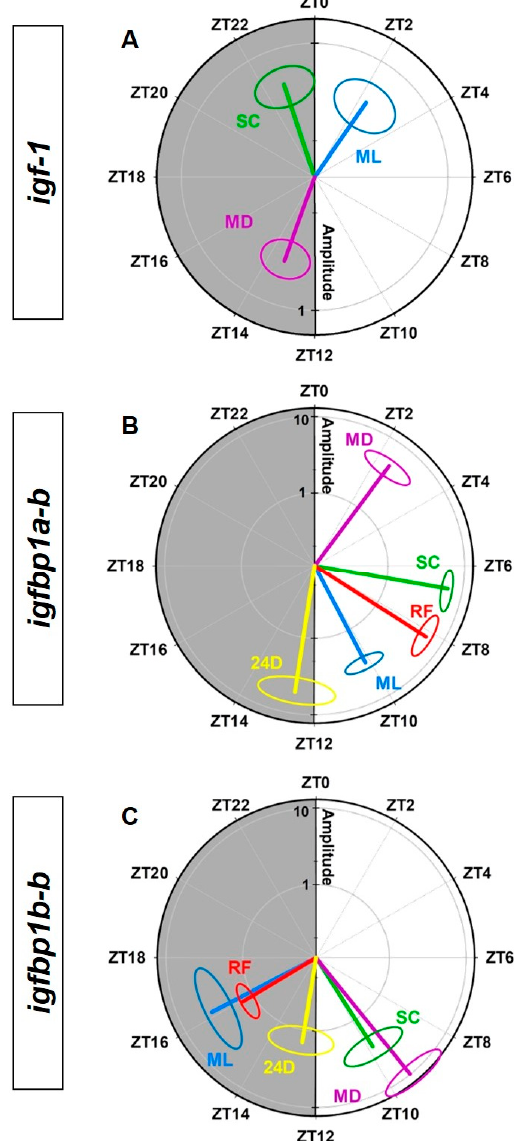
Figure 8. Polar representations of cosinor-derived rhythmic parameters of igf-1 ( A ), igfbp1a-b ( B ) and igfbp1b-b ( C ) gene expressions under the different experimental conditions. Amplitude and acrophase are represented by a single vector starting from the center. The length of the vector (radial axis) indicates the magnitude of the amplitude (fold change of relative expression,) and the phase angle of the vector represents the acrophase ( φ , ZT, Zeitgeber Time). The ellipse at the tip of